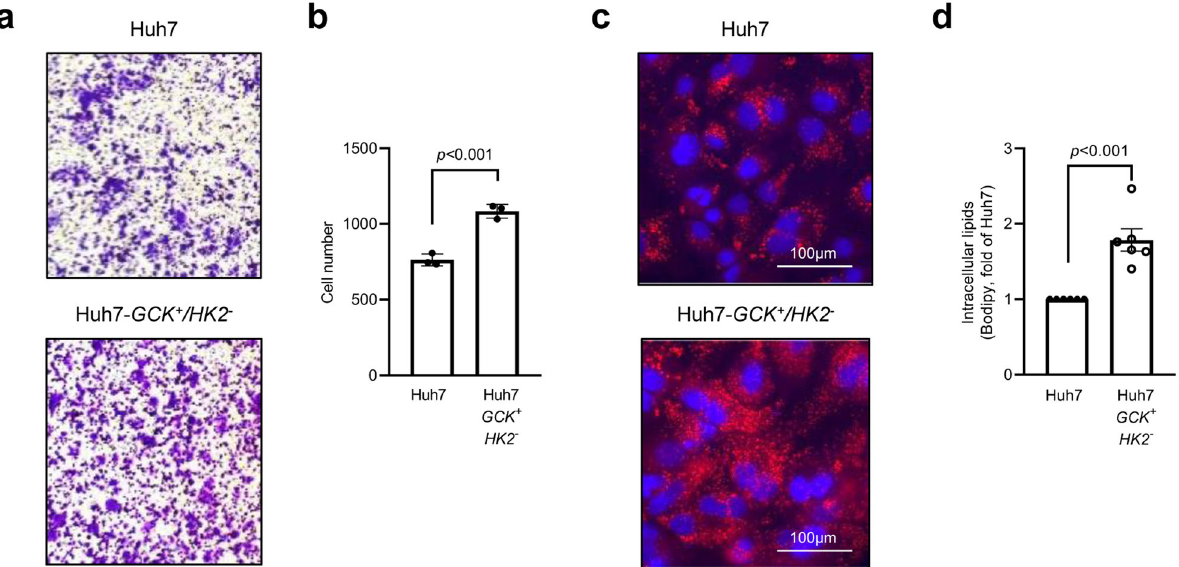
Fig. 3 Huh7- GCK + /HK2 − cells have a higher migration capacity and lipid droplets content. a , b Results of transwell-migration tests. a Representative images and b count of migrating cells ( n = 3). c Oil Red-O staining of lipid droplets (red) with nucleus counterstaining (blue). d Quanti fi cation of intracellular lipids by FACS after BODIPY staining ( n = 6). Means ± SEM are indicated and p values were determined by Student ’ s t -test.